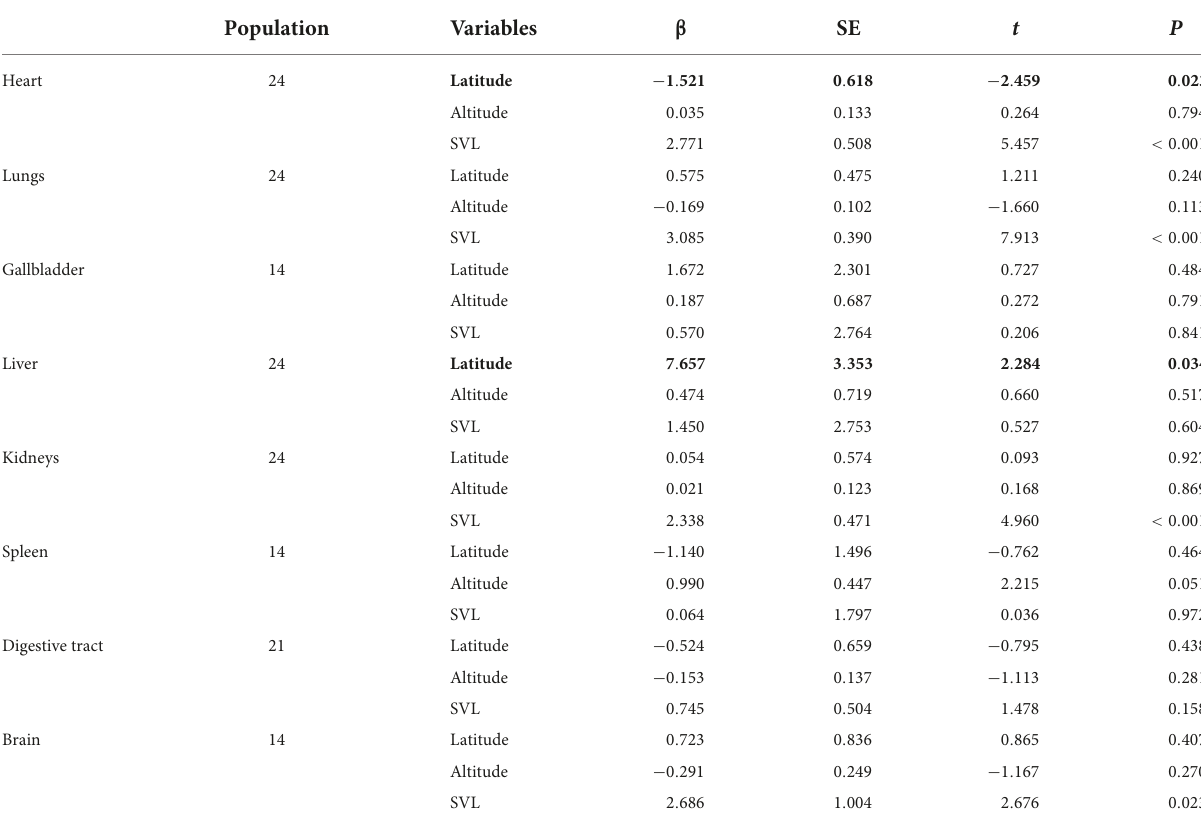
TABLE 3 The relationship between altitude and latitude and variation in mean organ size across all populations of the Andrew’s toads when correcting for snout–vent length